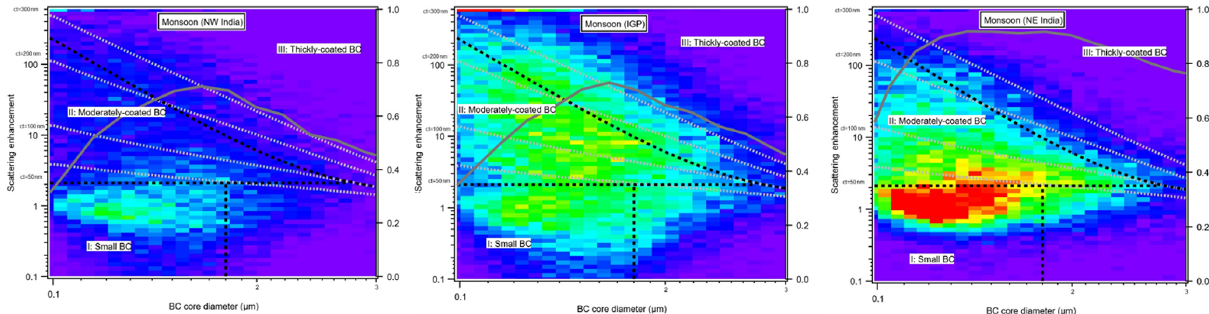
Figure 7. BC optical properties for the monsoon (M) season with the location sampled highlighted in the plot title. The plots present the scattering enhancement ( E s ) as a function of BC core diameter ( D c ). The image plot is a two-dimensional histogram for the detected particles. The dashed grey contours show the absolute coating thickness (nm, (D p − D c )/ 2). The solid grey line, with corresponding scale on right axis, shows the number fraction of BC particles that were successfully determined according to their scattering signal at each D c